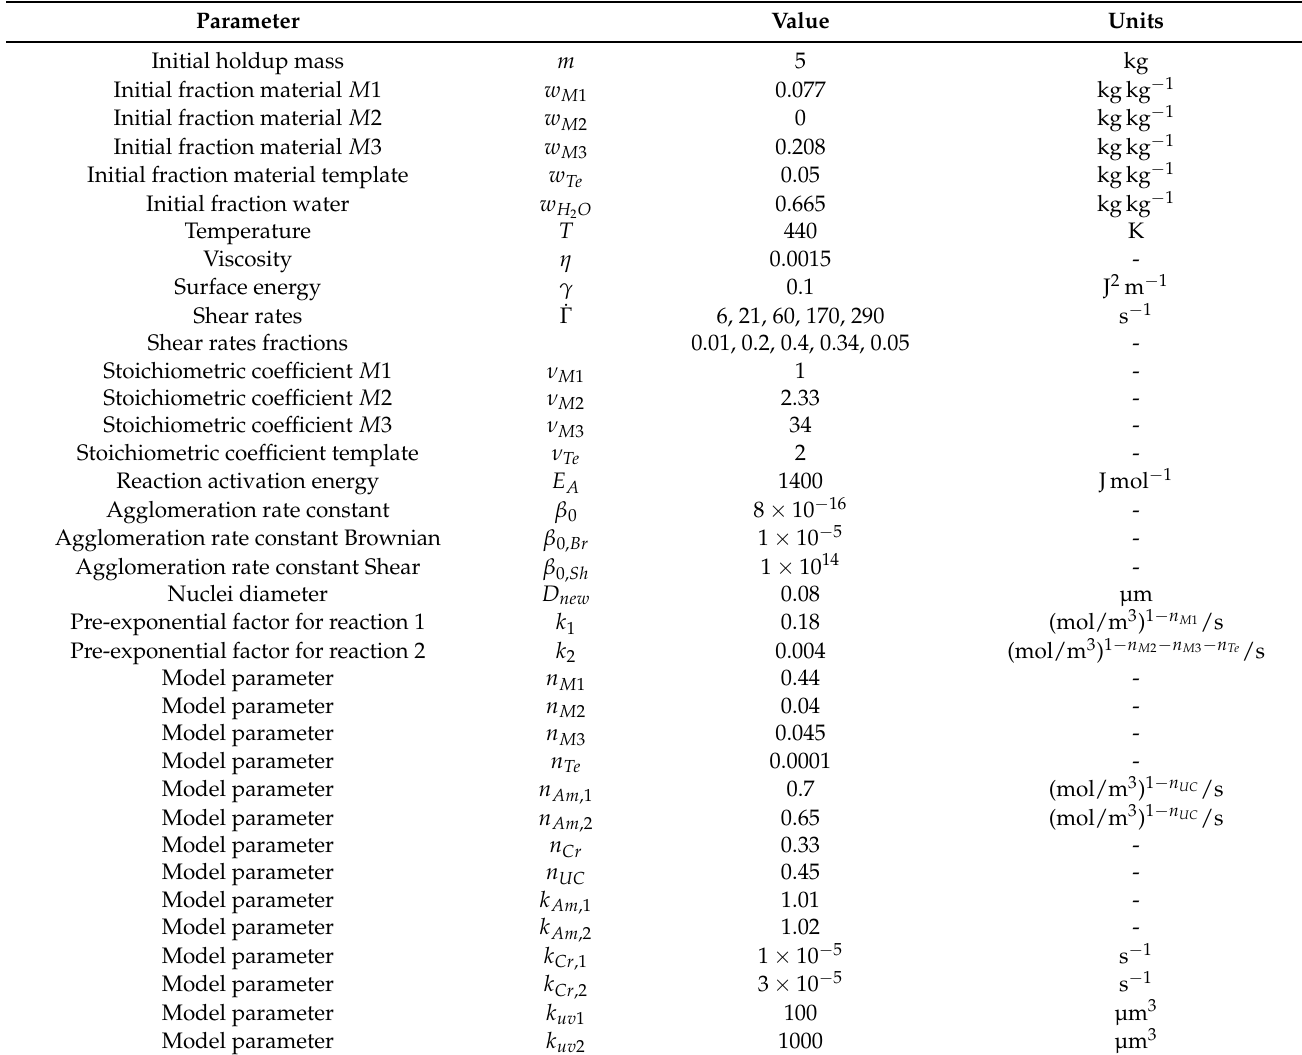
Table A2. Model parameters of the Synthesis reactor used in